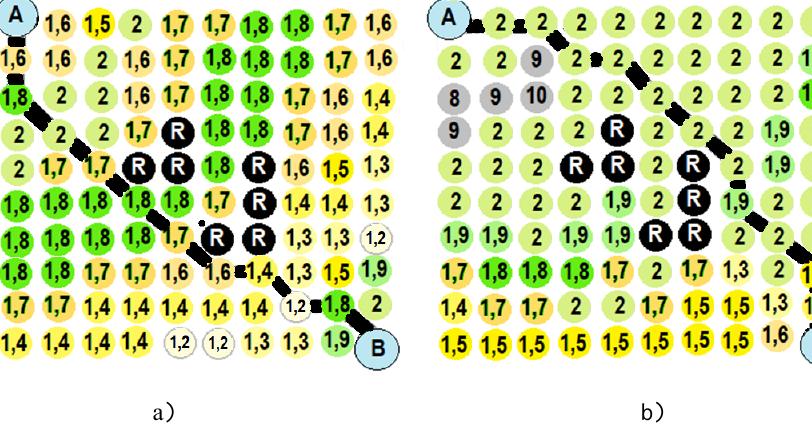
Fig. 6. Optimal routes in the presence of prohibited zones and significant PDOP variations.